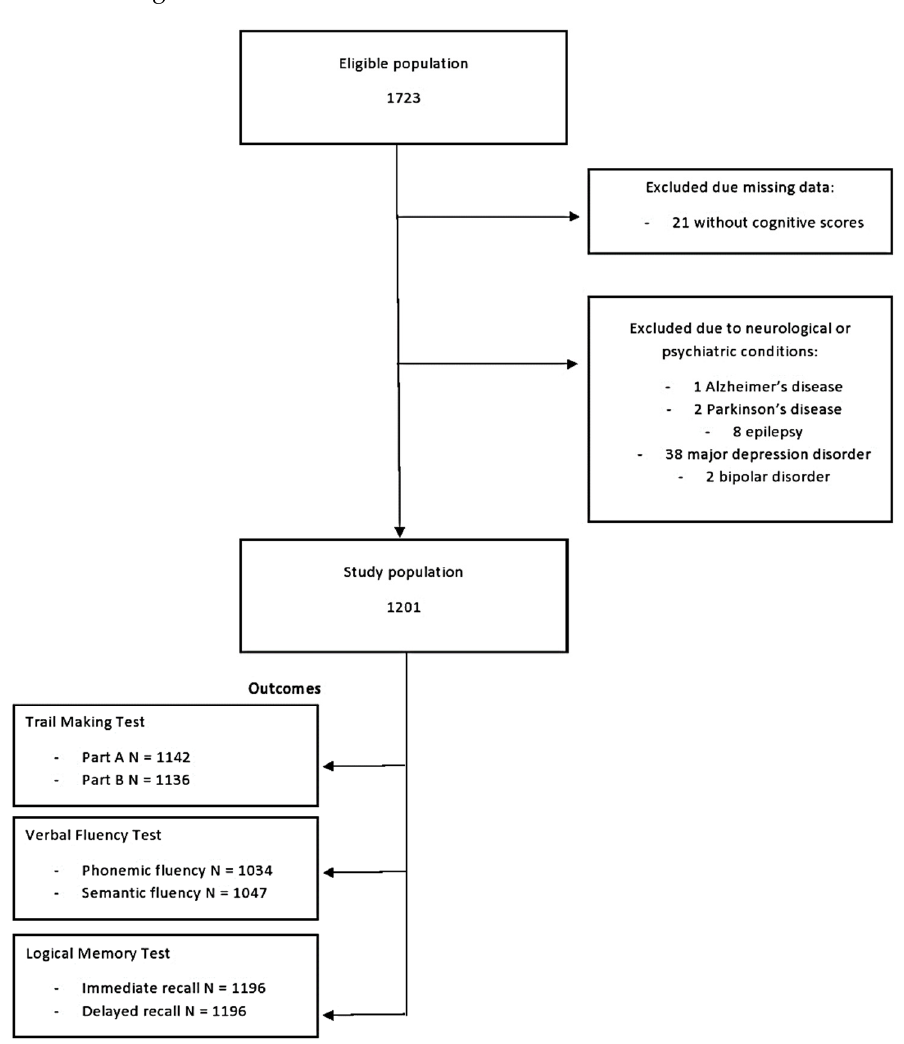
Figure 1. Flowchart for the identification of the study population. Each outcome was determined independent of the other outcomes.